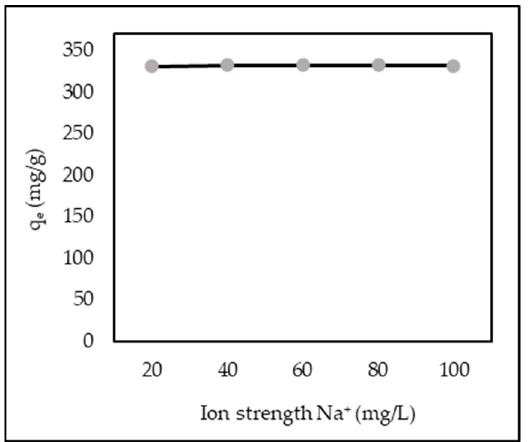
Figure 11. Effect of ionic strength (ZL–CH hydrogel = 30 mg, initial AR88 concentration = 100 mg/L, pH 2.0). pH